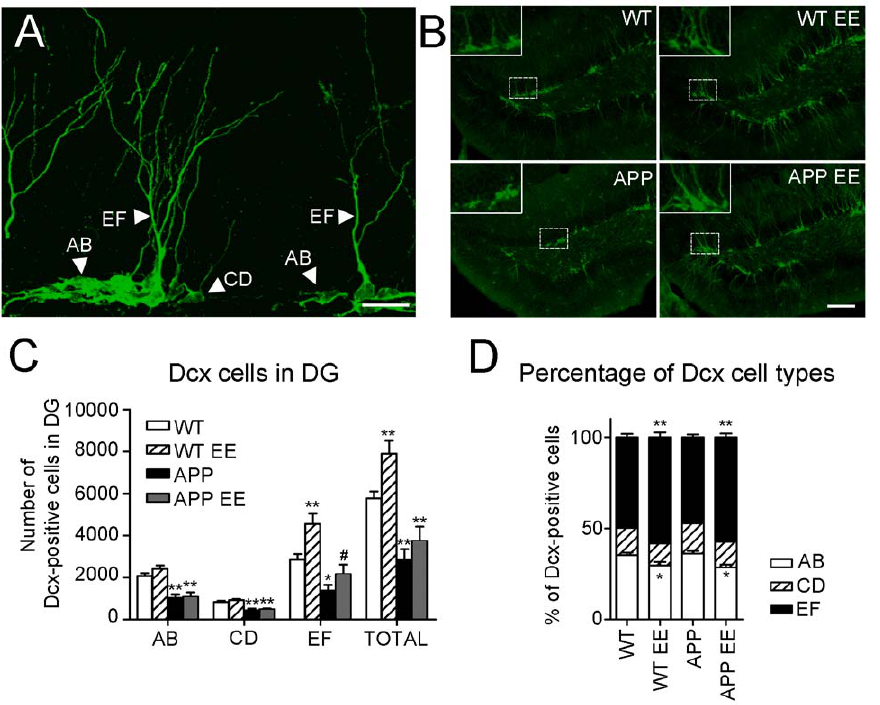
Figure 3. Environmental enrichment enhances the population of most-mature doublecortin cells in APP Sw,Ind mice. (A) Confocal microscopy image (maximum projection of several planes) of the dentate gyrus (DG) of an enriched WT mouse stained with doublecortin (Dcx) antibody showing the morphology of proliferative (type AB), intermediate (type CD) and postmitotic (type EF) neurons. Scale bar =20 m m. (B) Representative epifluorescence microscopy images showing Dcx positive cells in the DG of the four experimental groups. Magnified images are shown in the insets. Scale bar =100 m m. (C) Quantitative analysis reveals a significant reduction of total number of Dcx-labelled cells in the DG of APP Sw,Ind mice (n=6 mice) compared with WT mice (n=6 mice). The number of EF-type neurons, but not AB- and CD-type neurons, is significantly increased in both WT (n=6 mice) and APP Sw,Ind mice (n=6 mice) after EE. (D) Both enriched WT and APP Sw,Ind mice show a significant increase in the percentage of EF cells and reduced percentage of AB cells compared to standard housed mice. Data represent mean 6 SEM. *p , 0.05 and **p , 0.01, compared to WT mice. # p , 0.05, compared to APP mice.